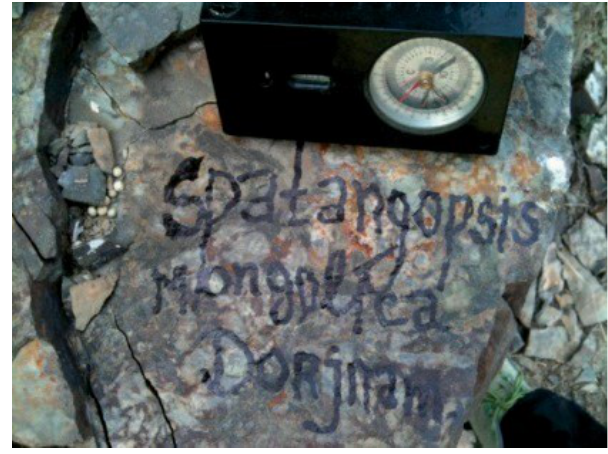
Fig. 6. New location of Spatangopsis mongolica Dorjnamjaa, phosphatic silty sandstone in the base of 18th bed of the Bayangol Formation indicative the limitotype boundary between Ediacaran and Lower Cambrian. Bayangol gorge.